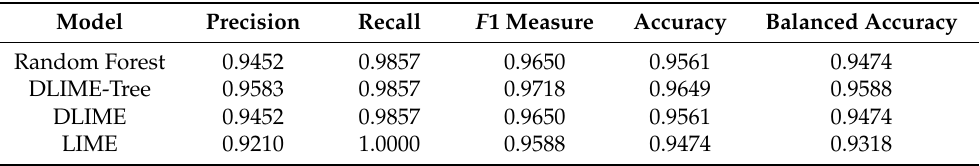
Table 3. Performance comparison on breast cancer dataset.